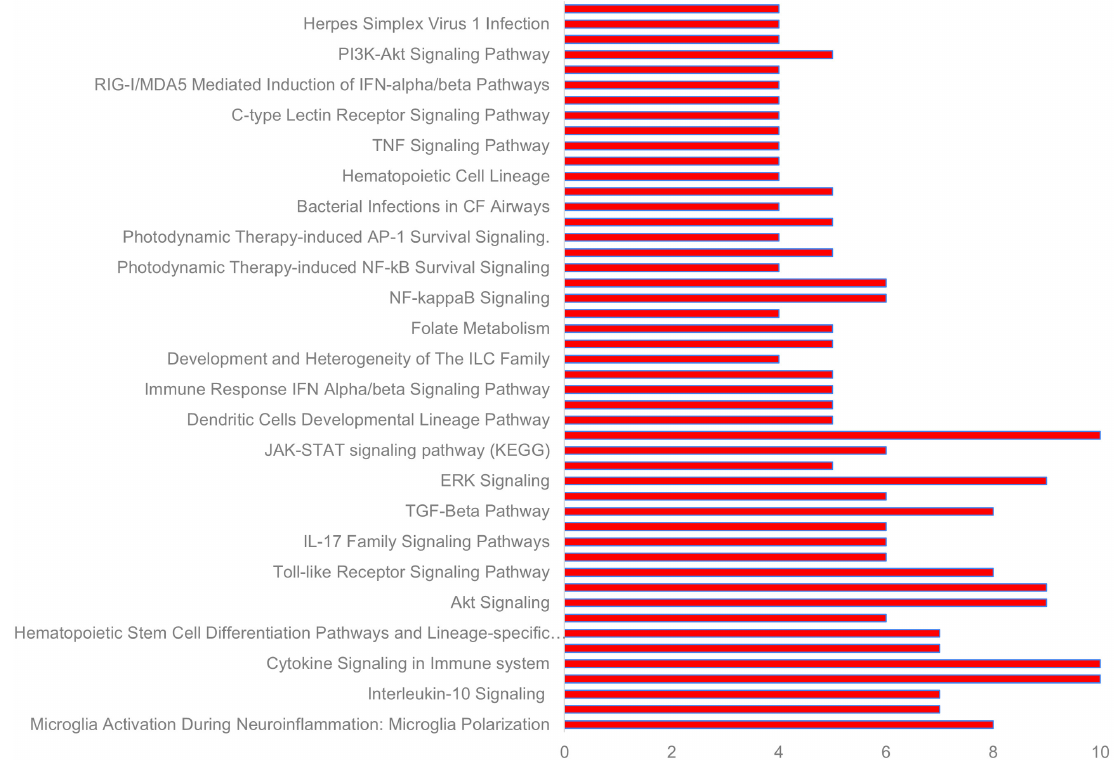
were found to be associated with the identified lncRNAs ( Table 5 ), The cancers identified are not localized, and span across multiple organ systems. The disease with the most hits, hepatocellular carcinoma, is associated with ten out of nineteen mapped